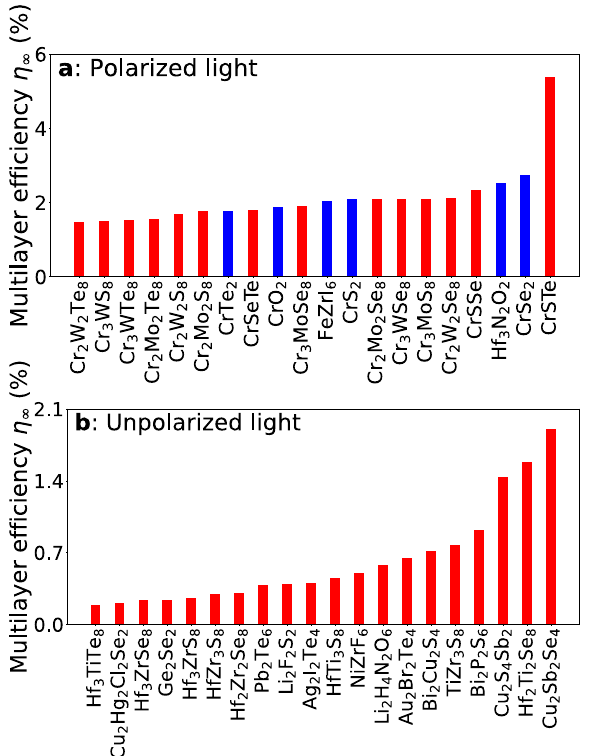
Fig. 4 Multilayer PV ef fi ciencies. Multilayer PV ef fi ciencies for the twenty most ef fi cient 2D materials, using parameters from C2DB and a standard solar spectrum, with a and without b polarization fi lter. The bar colors in a indicate polar (red) and non-polar (blue) compounds, respectively.